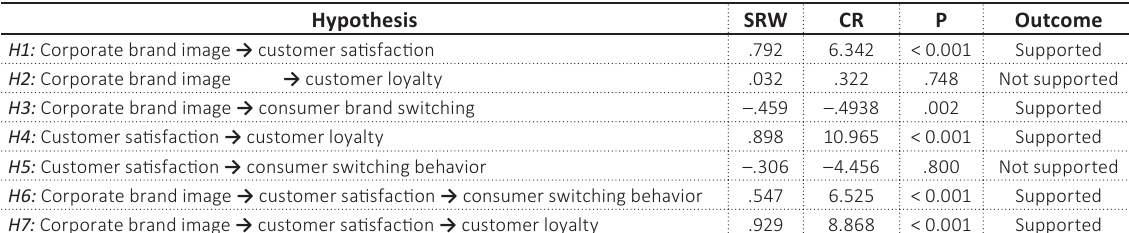
Table 3. Hypotheses testing